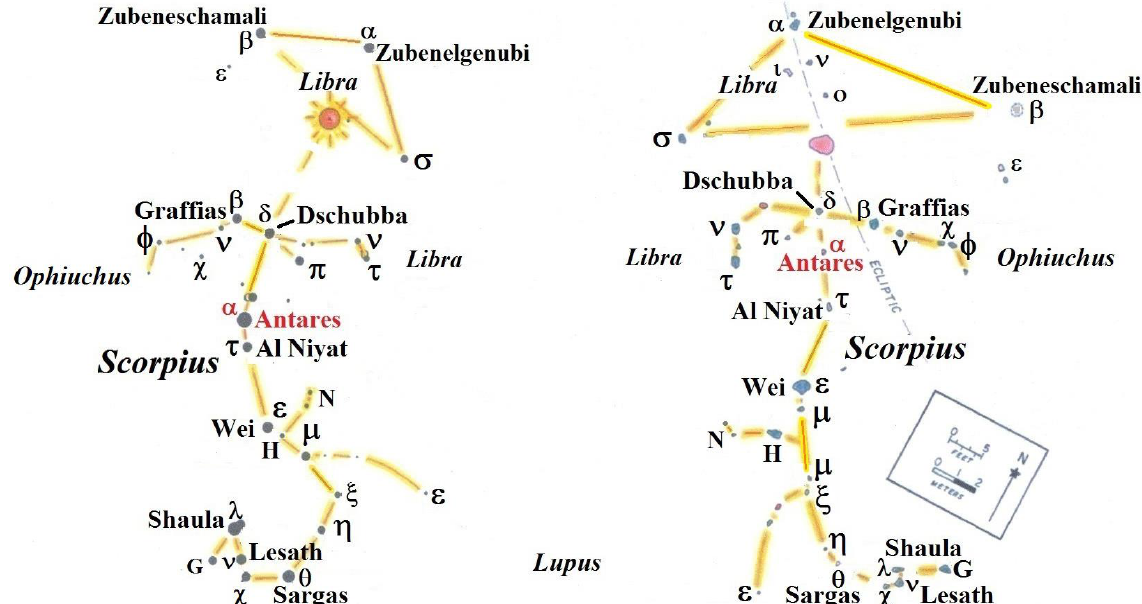
Figure 28. Illustration showing the Kolterman Star-Being (at right) as a mirror image of the western constellations Scorpius and Libra. Note that the individual stones in the lithic form can be annotated ‘rock for star’ when compared to the mirrored star map. The Star-Being’s red-coloured, bison-shaped headstone is in the same location in the stones making up the constellation that we call Libra as was the Sun during the autumnal equinox sunrise about 4000-2000